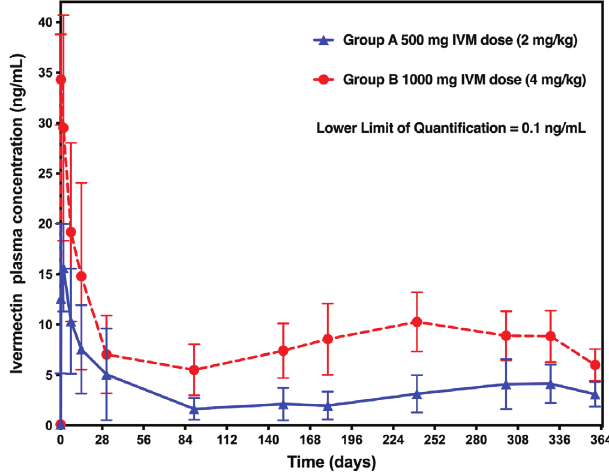
Figure 1. Plasma concentration-time pro fi les of IVM following subcutaneous injection of a long-acting formulation in cattle ( N = 4 per group). LLOQ = lower limit of quanti fi